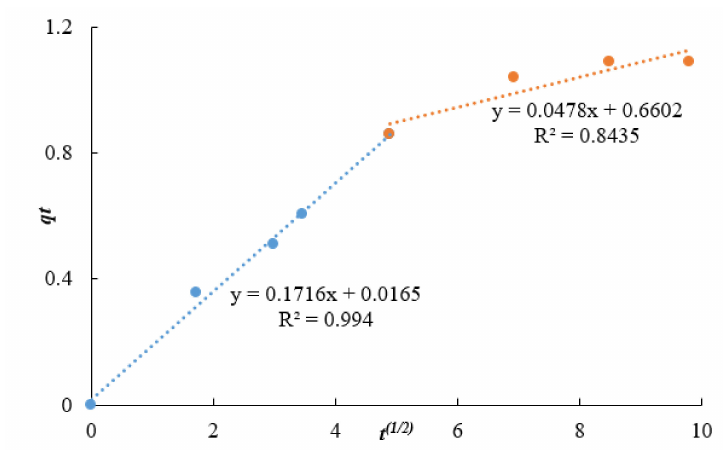
Figure 17. Intraparticle plot for the adsorption of Cr(VI) by the SDS-chitosan beads.